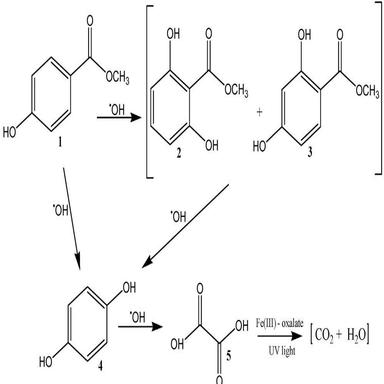
Reaction sequence for MetP mineralization by the PEF process using a Pd1%/PCL6/PW03 gas diffusion cathode and a BDD anode.